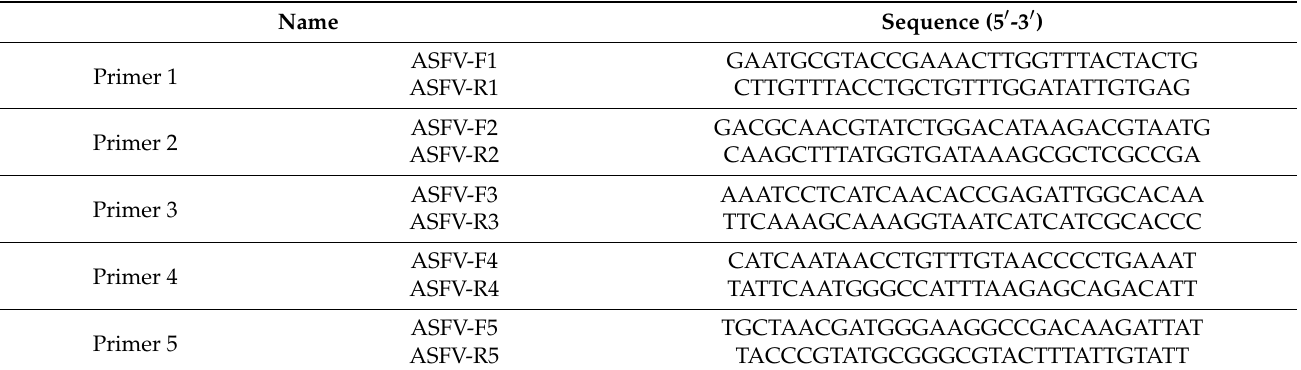
Table 1. Sequences of the recombinase-aided amplification (RAA) primers.